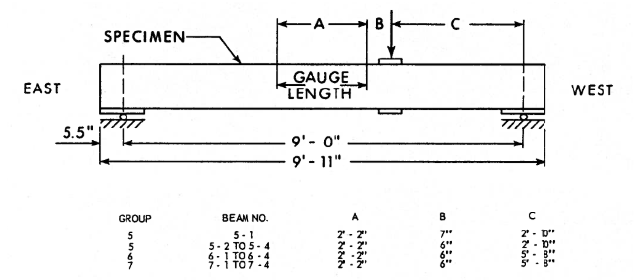
Figure 18: Test setup for combined action on beams M5 a M7 [21].